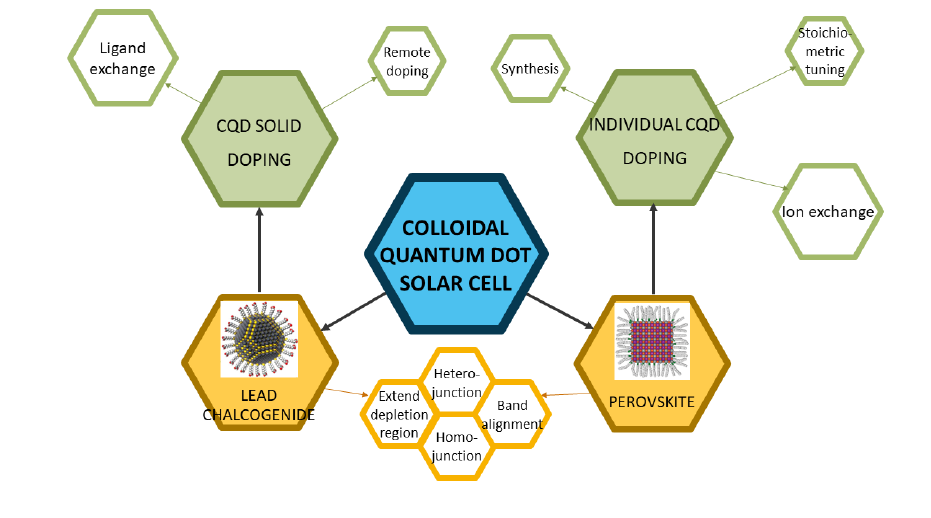
Figure 1. The overall framework of this review. Reprinted with permission from [7,8]. Copyright 2015 and 2019 American Chemical